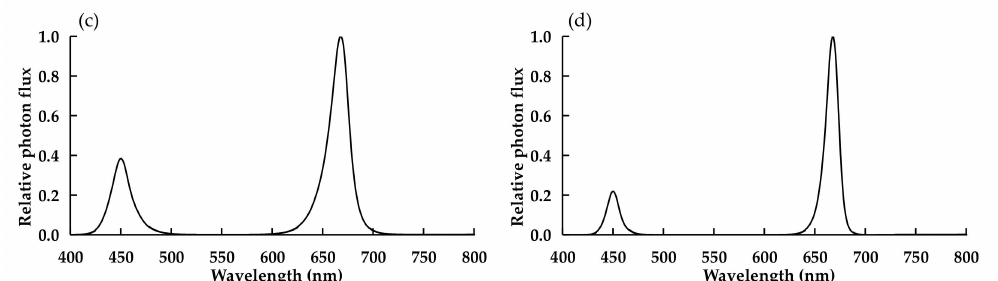
Figure 6. Spectral photon flux distributions of white LED lamp (customized lamp) in Experiment 1 ( a ), white LED lamp (LDL40S-N19/21) in Experiment 2 ( b ), as well as red and blue LED lamps in R3B1 ( c ) and R9B1 ( d ) in Experiment 2. R3B1 and R9B1 represent photon flux ratios (red to blue light) of 3:1 and 9:1, respectively. The peak wavelengths of the white lamp were 446 nm and 592 nm in Experiment 1 and 454 nm and 593 nm in Experiment 2. The peak wavelengths of red and blue light were 667 and 450 nm, respectively, in Experiment 2. The maximum value of photon flux was converted to